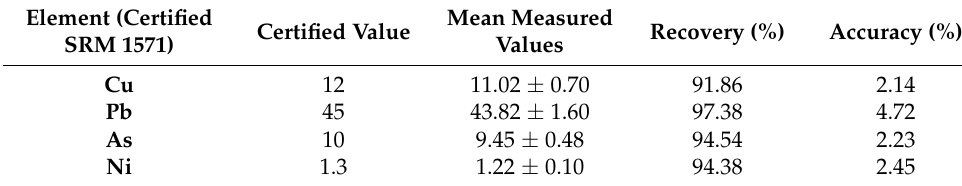
Table 2. Analytical results obtained on certified reference materials